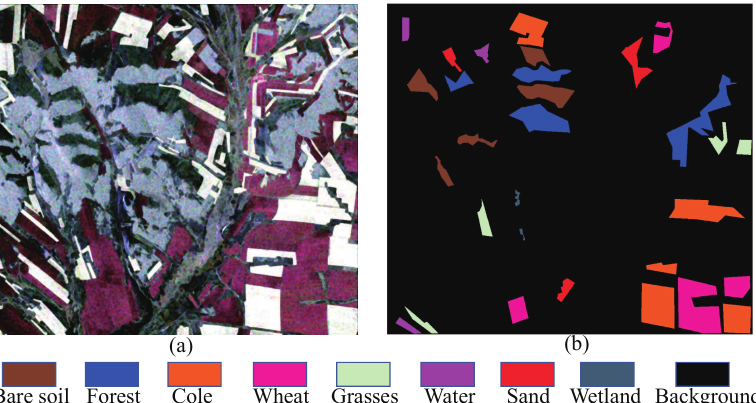
Figure 7. GF-3 dataset. ( a ) PauliRGB image (Red: double-bounce scattering power. Green: volume scattering power. Blue: surface scattering power). ( b ) Ground truth